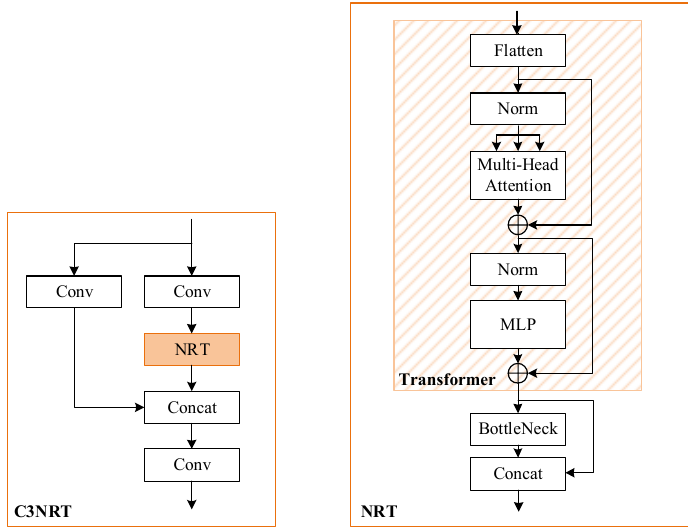
Figure 4. The structures of C3NRT and NRT.